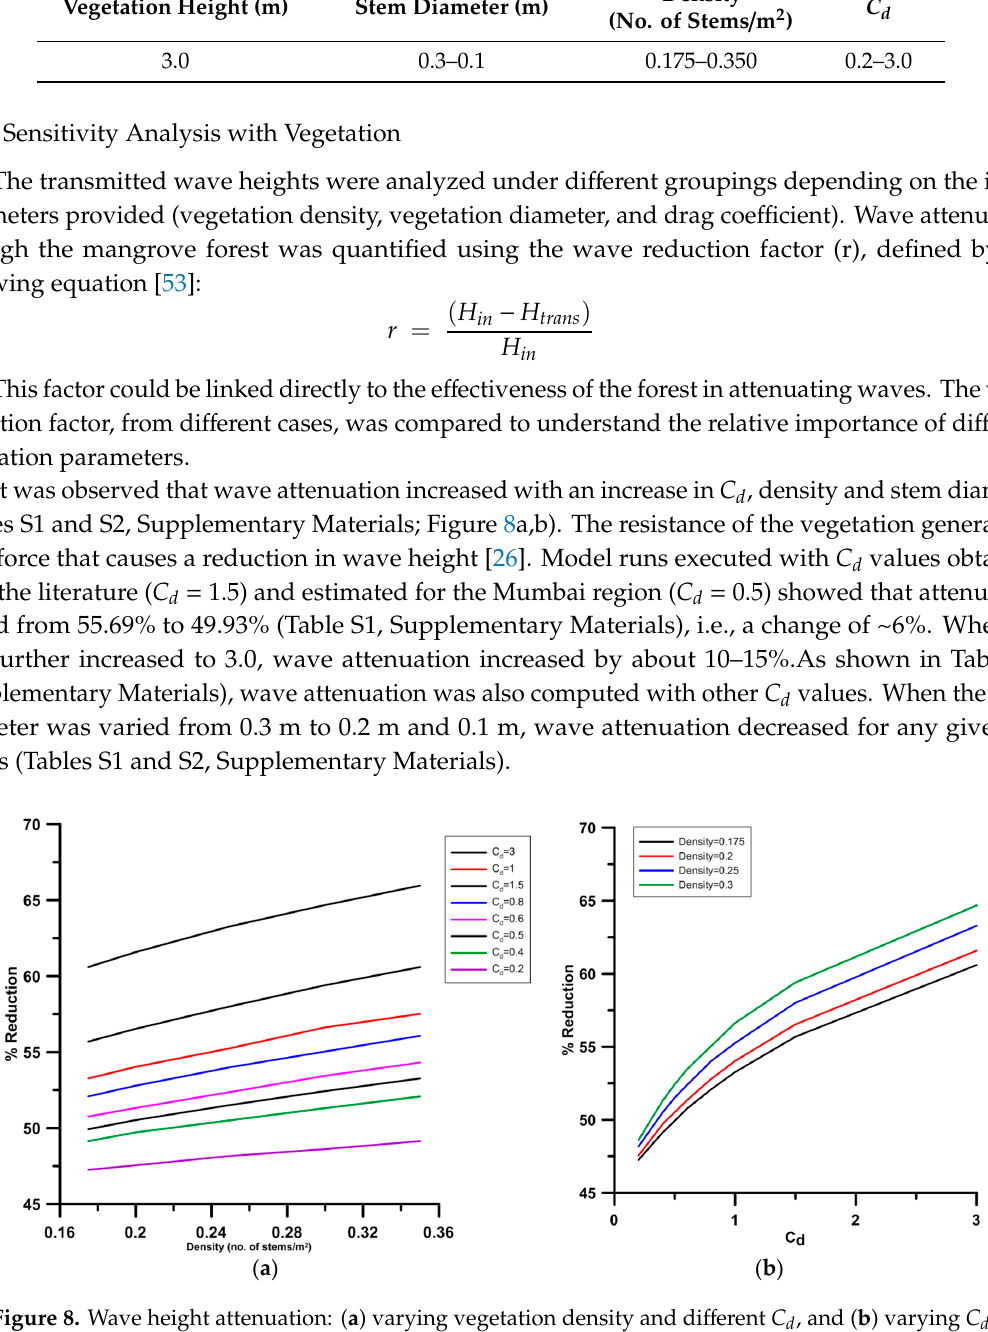
Table 2. Range of vegetation parameters considered for various model runs.